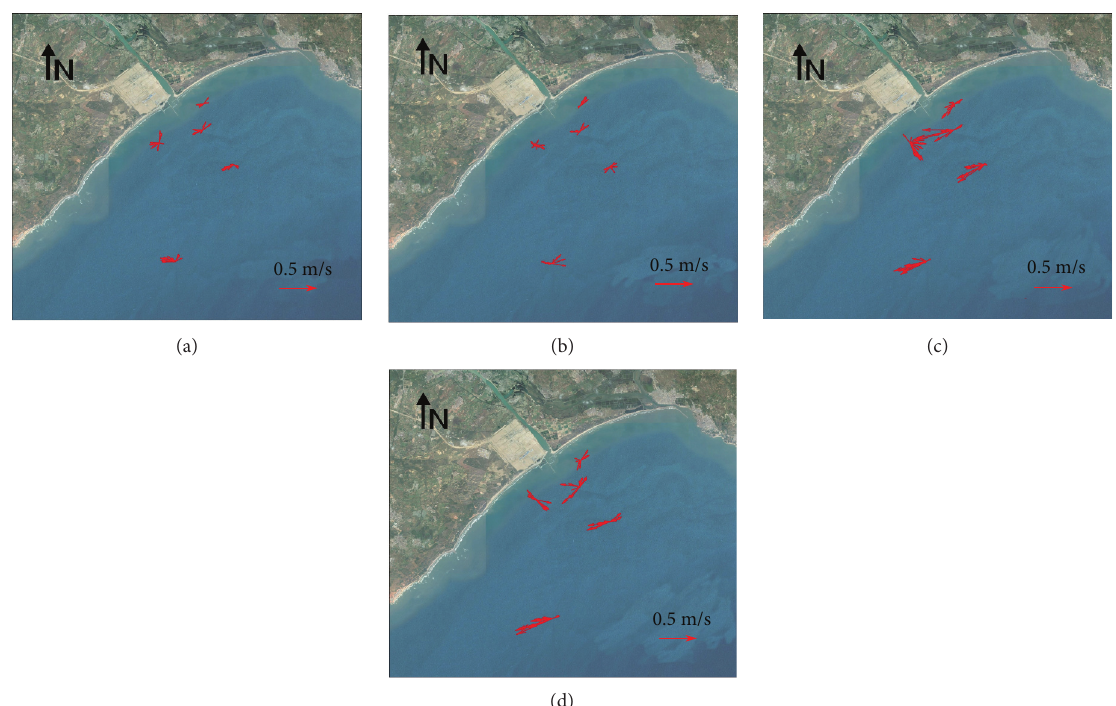
Figure 6: Tidal current vector diagram of tidal current and sediment observation in the study sea region, the velocity vectors indicate the depth average velocity. (a) The first tide cycle of the spring tide; (b) the second tide cycle of the spring tide; (c) the first cycle of the neap tide; (d) the second cycle of the neap tide.